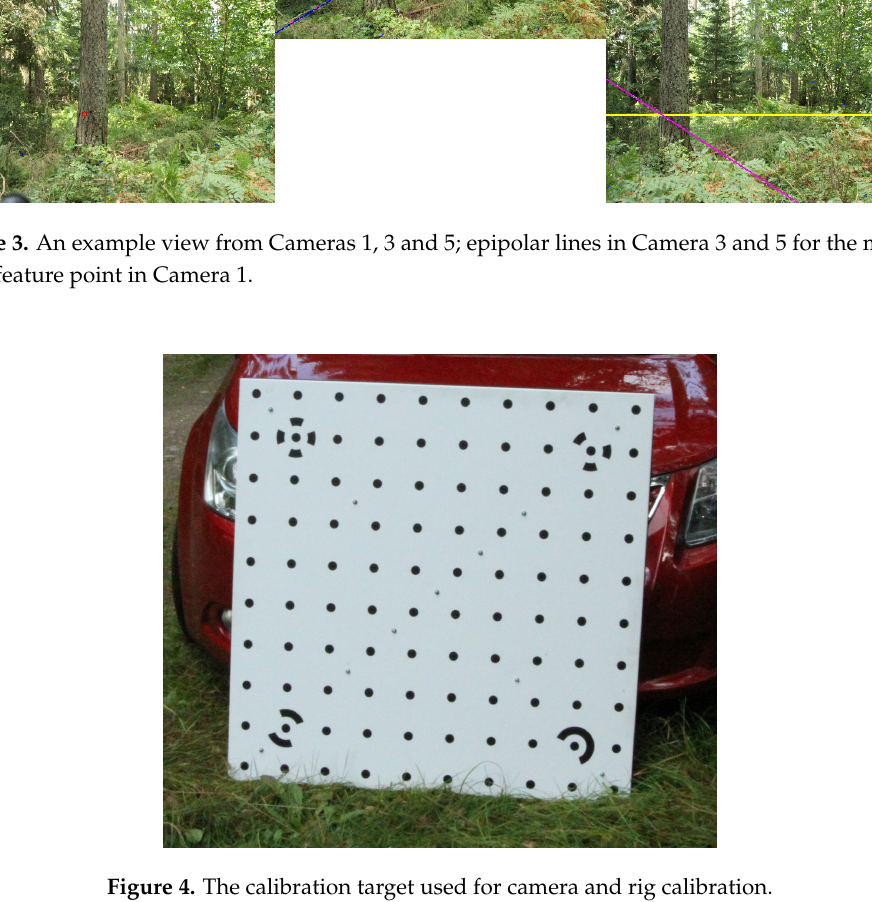
Figure 4. The calibration target used for camera and rig